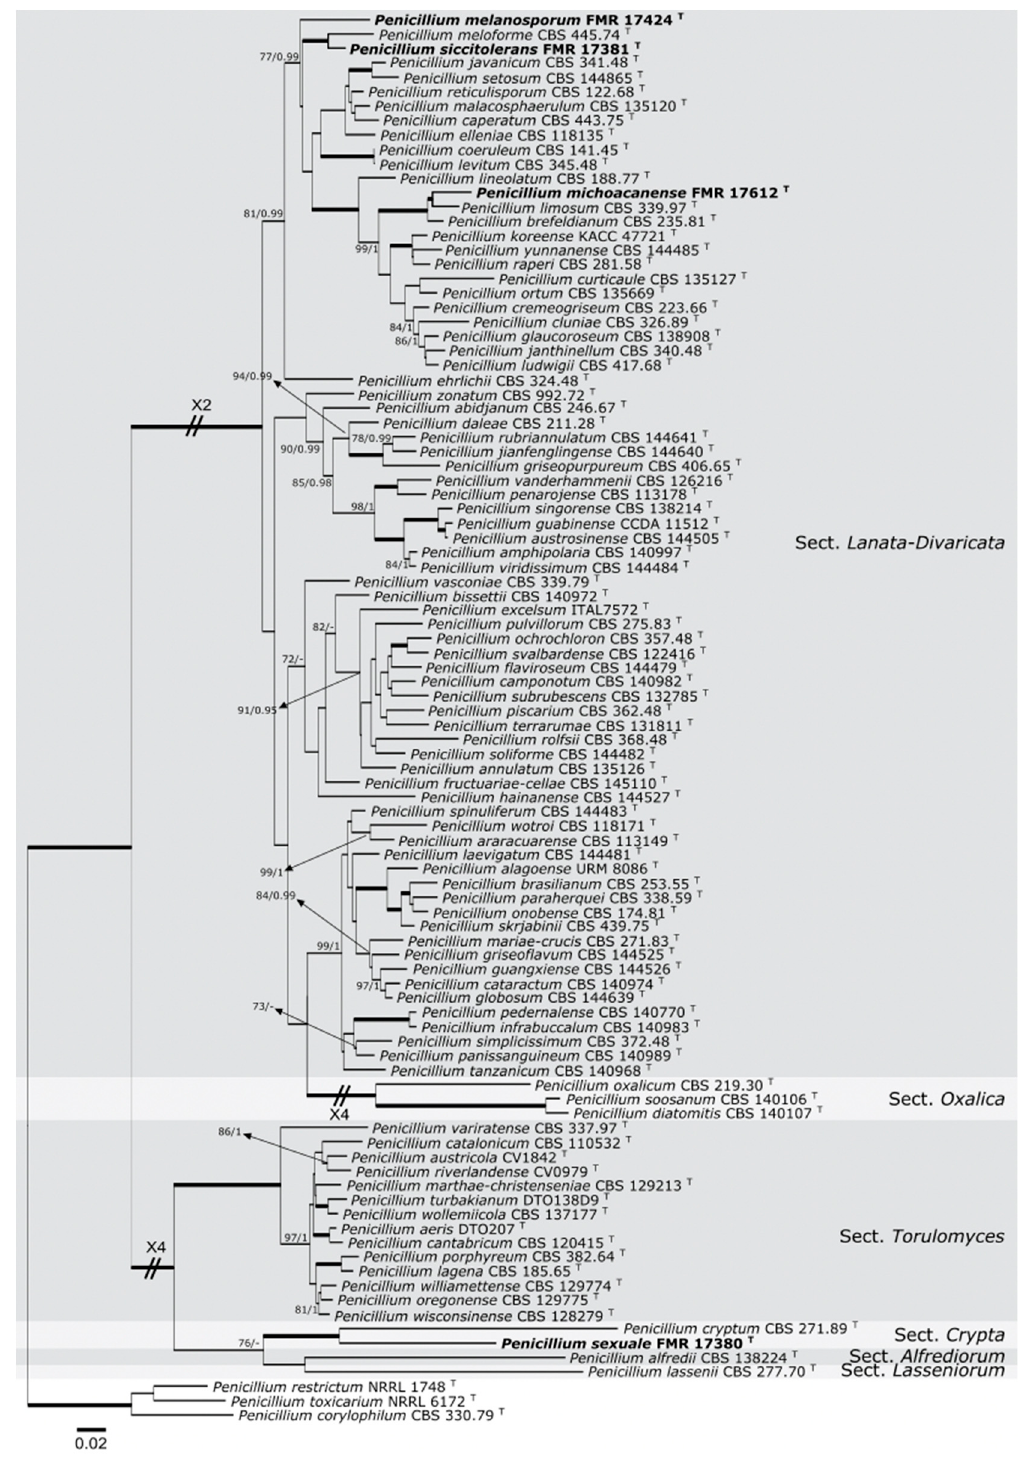
Figure 1. Maximum-likelihood (ML) phylogenetic tree of Penicillium section Alfrediorum , Crypta , Lanata-Divaricata , Lasseniorum , Oxalica, and Torulomyces inferred from the combined internal transcribed spacer (ITS), beta-tubulin ( BenA ), calmodulin ( CaM ) , and RNA polymerase II subunit 2 gene ( rpb 2) loci. Support in nodes is indicated above thick branches and is represented by posterior probabilities (Bayesian inference (BI) analysis) of 0.95 and higher and/or bootstrap values (ML analysis) of 70% and higher. Some branches were shortened; these are indicated by two diagonal lines with the number of times a branch was shortened. Fully supported branched (100% BS/1 PP) are indicated in bold . T =ex-type strains. Alignment length 2249 bp. The sequences not generated by us were retrieved from EMBL/GenBank and are indicated in Supplementary Table S1.